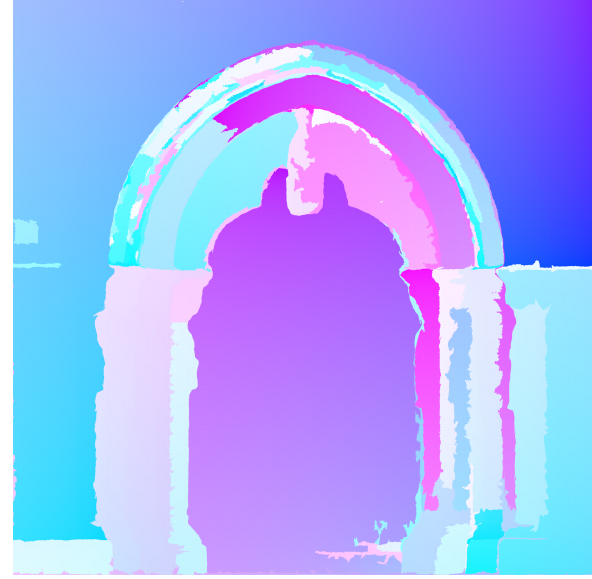
Figure 5: Colour coded UV map, to arbitrarily reassign 3D model coordinates to the 2D texture coordinates of the multiple maps.